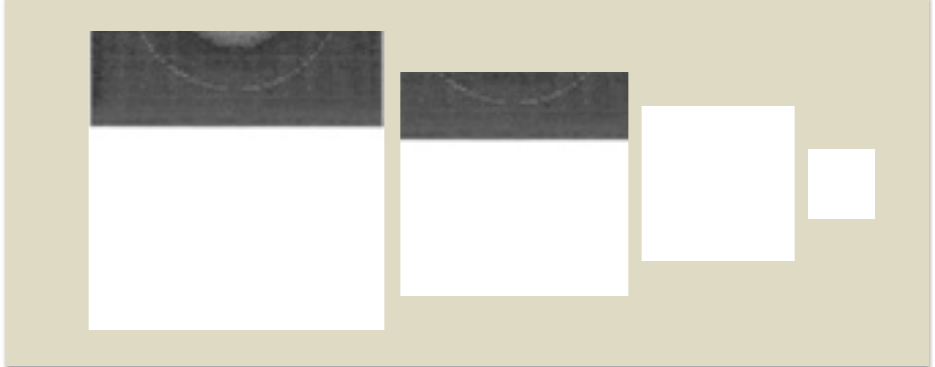
Figure 3. A schematic illustration of how the pixel dimension relative to the size of the Airy disc affects the amount of energy that is incident on and absorbed by the detector pixel.